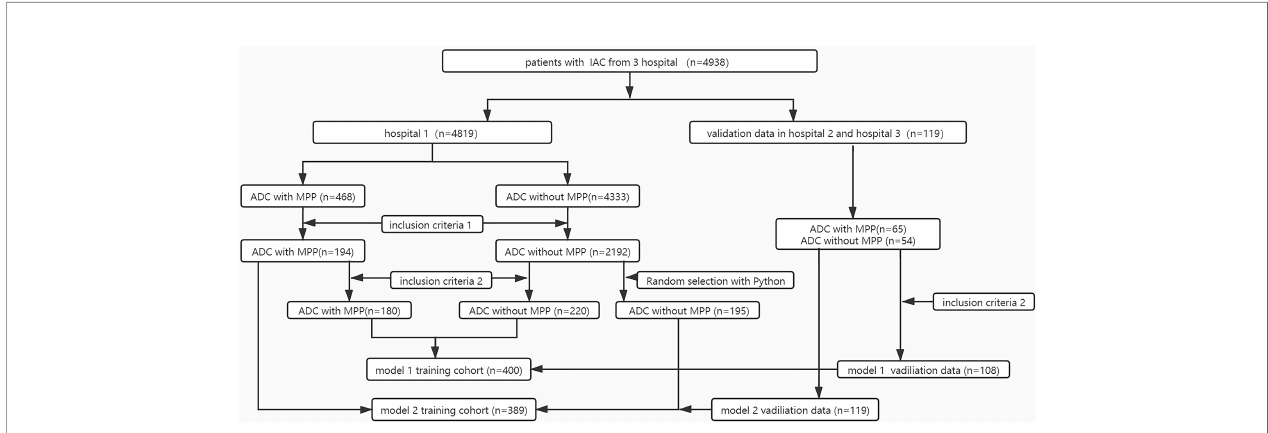
FIGURE 1 | Flowchart selection patients of the two-model dataset. Inclusion criteria 1: tumor size measured in CT images <2 cm;2) the presence of peripheral nodules on chest CT; 3) the lesions without marked cavity;4) histologic subtype without solid pattern; Inclusion criteria 2: the nodule manifest as solid on chest